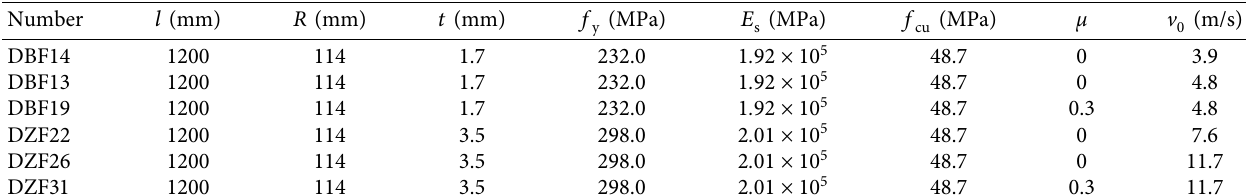
Table 1: Test information of CFST members [10].